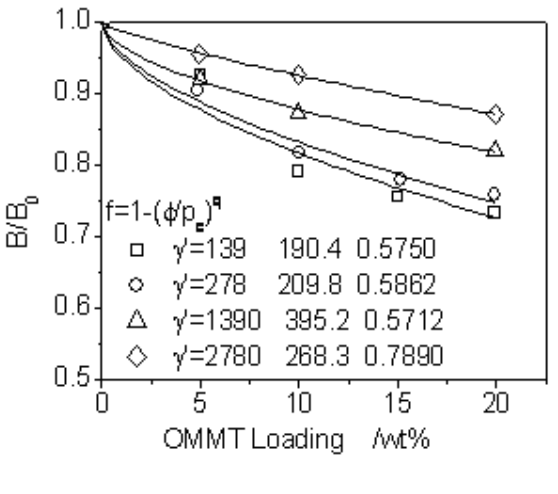
Figure 5. Relative die-swell as a function of OMMT content at four different shear